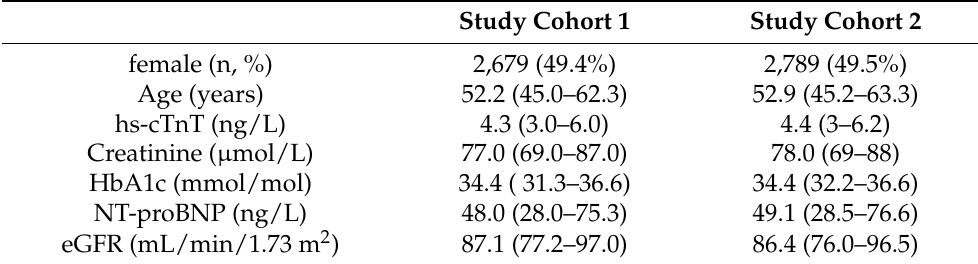
Table 1. Baseline characteristics of the study cohorts. Study cohort 1 (used for the calculation of age-specific and sex-specific upper reference limits) included subjects with preserved renal function only, whereas study cohort 2 (for the analysis of the relationship between hs-cTnT and kidney function) included an additional 208 individuals with an eGFR < 60 mL/min/1.73 m 2 . Age and laboratory parameters are presented as medians (interquartile range). Hs-cTnT: highly sensitive cardiac troponin T; HbA1c: hemoglobin A1c; NT-proBNP: amino-terminus pro B-type natriuretic peptide; eGFR: estimated glomerular filtration